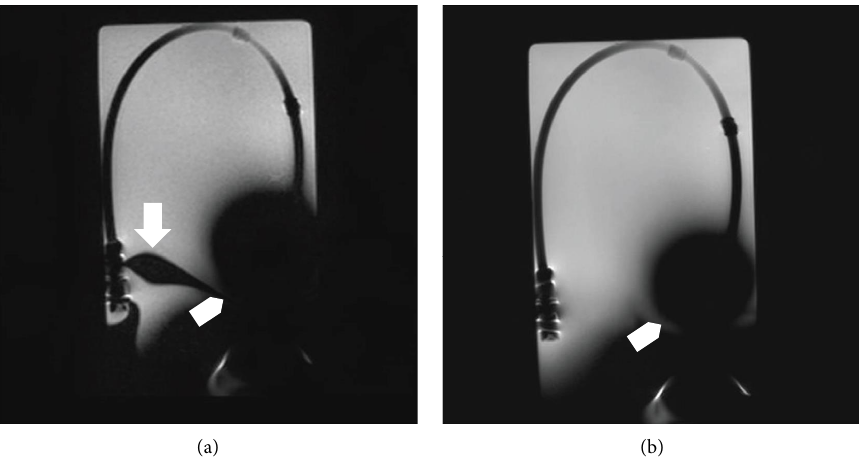
Figure 3: (a) Coronal fast gradient-echo T1-weighted and (b) coronal fast spin-echo T2-weighted images that demonstrate the extensive paramagnetic artifact with the “signal hole” of the tip tungsten ballast (arrowhead), the minor artifacts of the titanium connector (arrow), and the good visibility of the catheter.